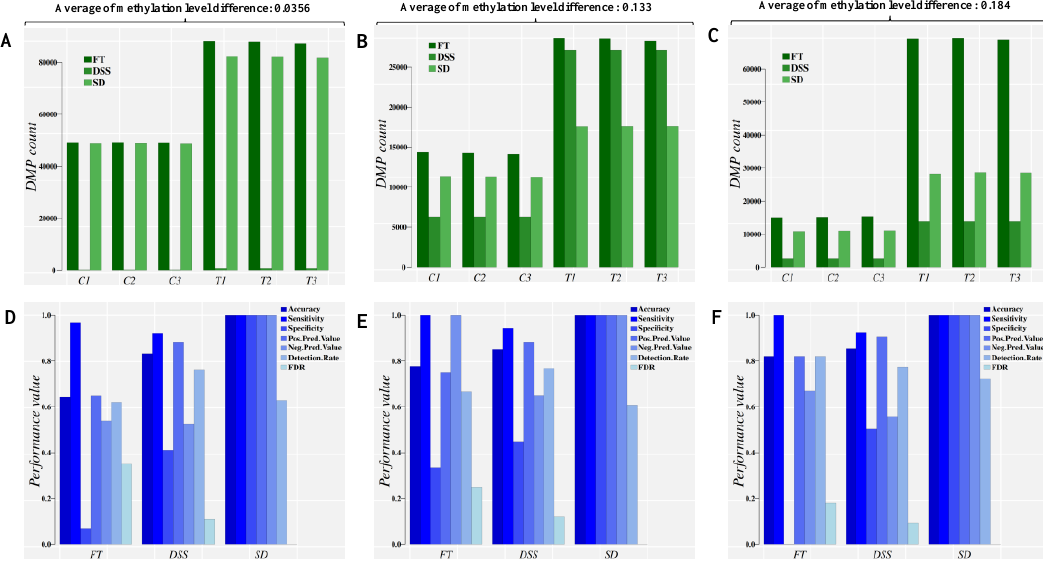
Figure 3. Direct comparison of the classification performance for control and treatment DMPs based on three different approaches and at three different averages of absolute methylation level differences (mild difference, 0.0356, medium difference, 0.133 and large difference, 0.184). Panels ( A – C ) report the sum of DMPs detected, while panels ( D – F ) report the sum of main classifier performance indicators. An extended list of performance indicators is given in the supplementary information. C1-C3: control individuals. T1–T3: Treatment individuals. FT: Fisher’s exact test, used by methylKit [15]. DSS: